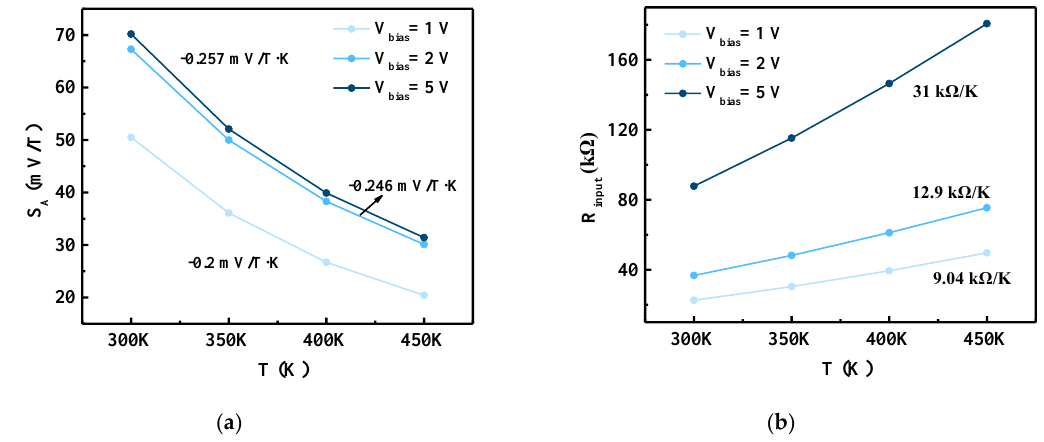
Figure 9. Simulated ( a ) absolute sensitivity ( S A ) and ( b ) input resistance ( R input ) as a function of temperature ( T ) with different bias voltages ( V bias ). The numbers in the figure are the slopes of linear fitting.